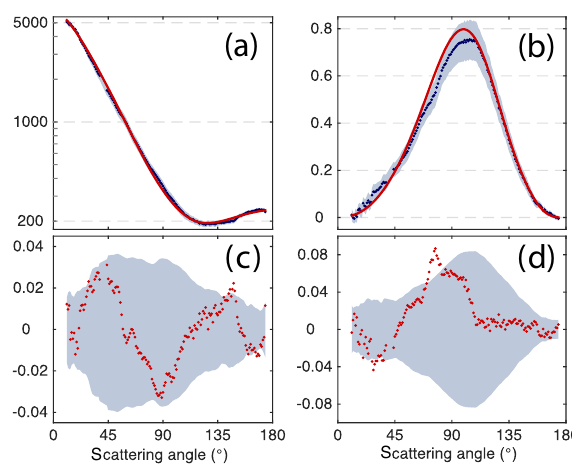
Figure 4. PI-Neph measurements at 532nm (points) with 2 σ in- strumental error (gray fill) and the GRASP retrieval best fit (solid line) for ammonium sulfate measurements made in the laboratory. (a) shows absolute F 11 (Mm − 1 sr − 1 ) data plotted on a log scale, while (b) shows − F 12 /F 11 data on a linear scale. (c) shows the F 11 differences according to the log transformation described in Eq. (1), while the conventional residuals in − F 12 /F 11 , as given by Eq. (2), are plotted in (d)